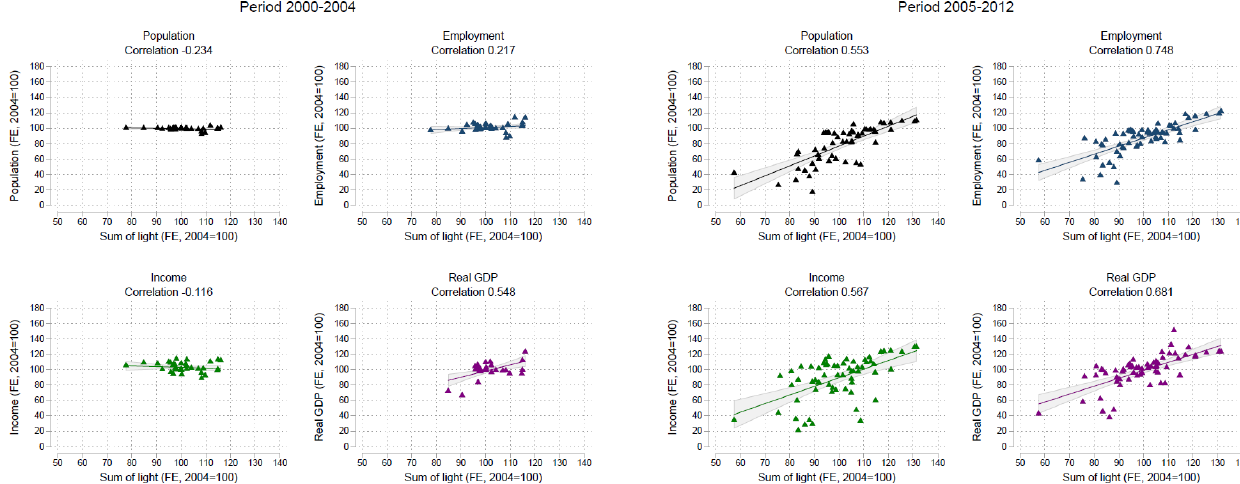
Figure A8. Indexed economic indicators and total sum of light for the eight affected counties before Katrina. Night lights based on fixed- effects correction, indexed to 2004 = 100. See Appendix B for methodology. Right panel: population data are for 2006–2012 only.